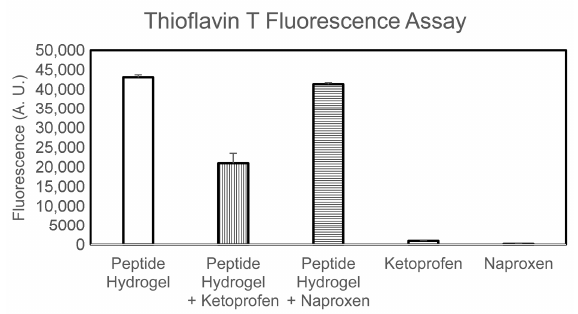
Figure 5. Thioflavin T fluorescence assay.